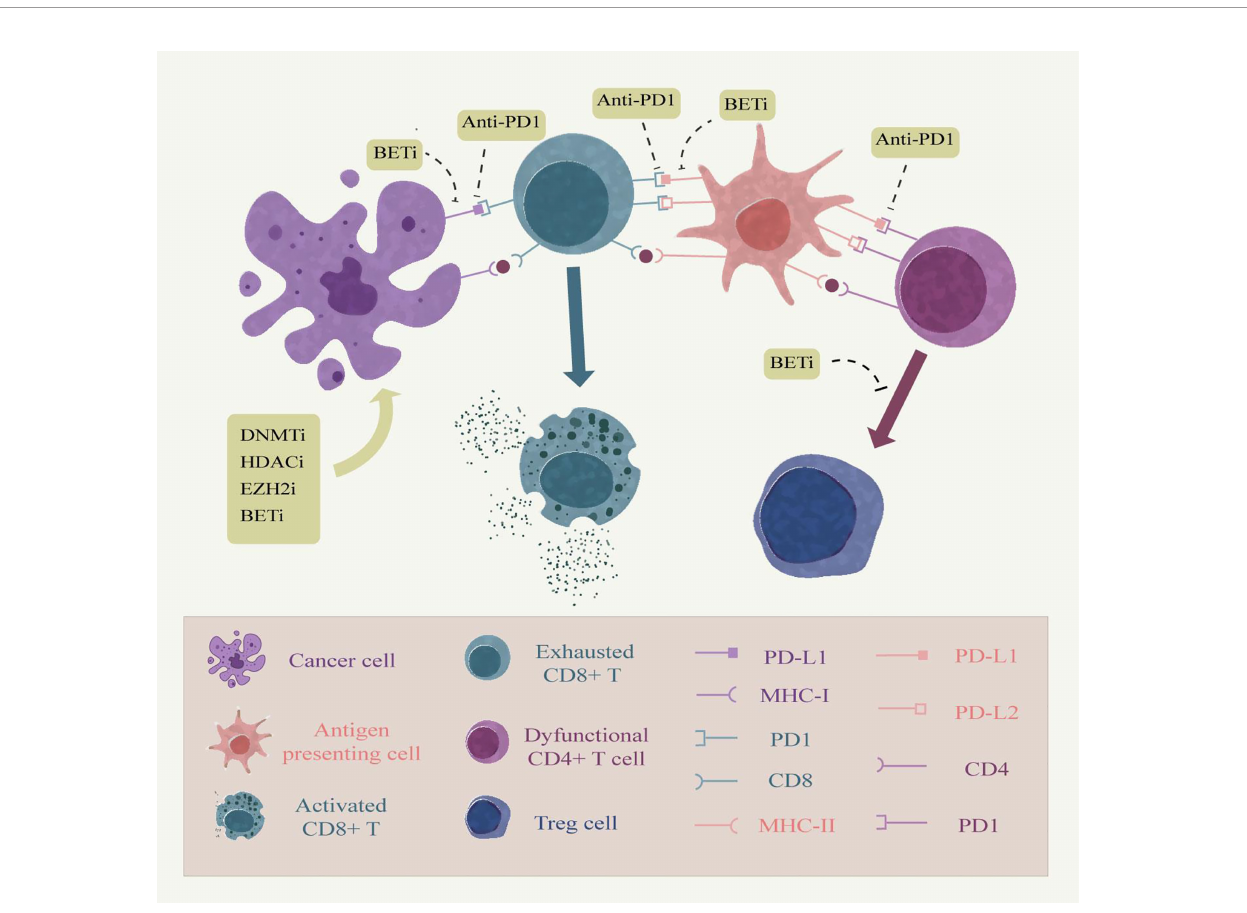
FIGURE 2 | Combining epigenetic drugs with immune checkpoint inhibitors. Persistent antigen stimulation and in fl ammatory factors in chronic in fl ammation can cause dysfunction of tumor-in fi ltrating T cells, up-regulation of immune checkpoints, and production of immune evasion, which are associated with epigenetic modi fi cations. Anti-PD-1 relieves the inhibitory effect of the epidemic checkpoint on tumor cells and antigen presenting cells by blocking the binding of PD-1 to its ligands PD-L1 and PD-L2 in the tumor microenvironment. Epigenetic modi fi ers can enhance antigen presentation by tumor cells, thereby enhancing the immune effects of T cells. Moreover, epigenetic modi fi ers inhibitors, such as BET, can also inhibit the expression of PD-L1 on the surface of tumor cells and tumor-in fi ltrating immune cells. Moreover, EZH2 inhibitors prevent the conversion of CD4 T cells into Treg cells to up-regulate the immune response of other cells. Therefore, the combination therapy of epigenetic modi fi ers with immune checkpoint inhibitors embodies great